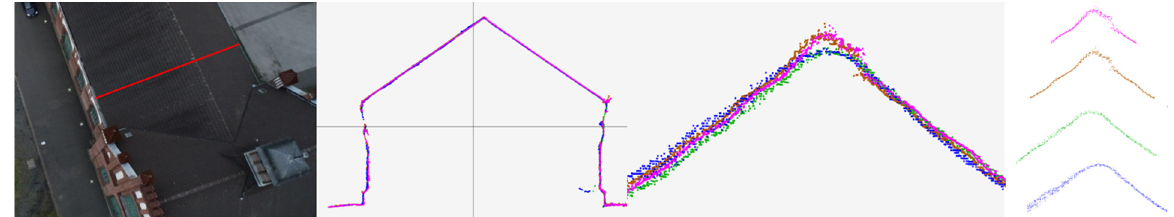
Figure 10. F.l.t.r.: Photo with profile of a building, reference point cloud from terrestrial laser scanning, dense point cloud profiles from image-based generation P4D JPG80 (pink), P4D TIF (brown), PS JPG80 (green) and PS TIF